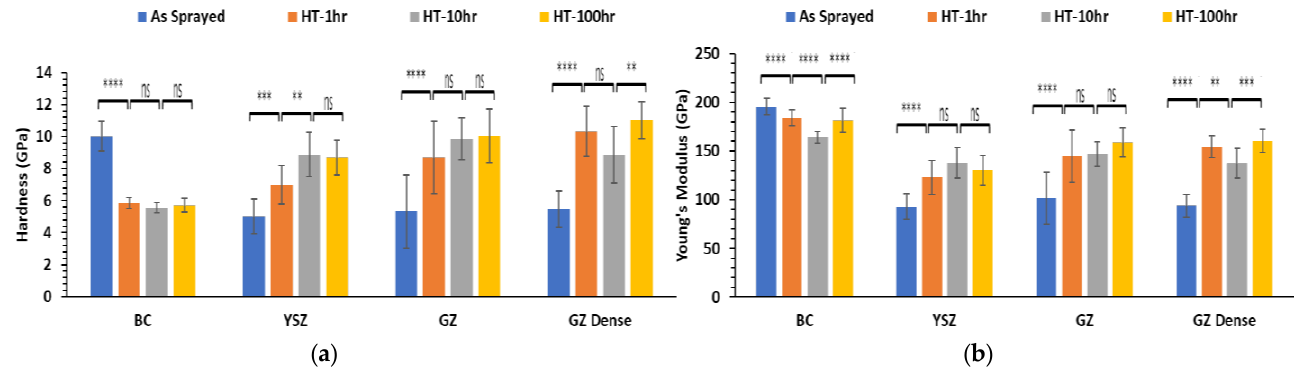
Figure 15. Nanoindentation data of the triple layer TBC before and after thermal treatment ( a ) hardness (H), ( b ) elastic modulus (E). Asterisks indicate a statistical difference (* p < 0.05, ** p < 0.01, *** p < 0.001, **** p < 0.0001, obtained using Tukey test, which computes a confidence interval for the difference between two means).